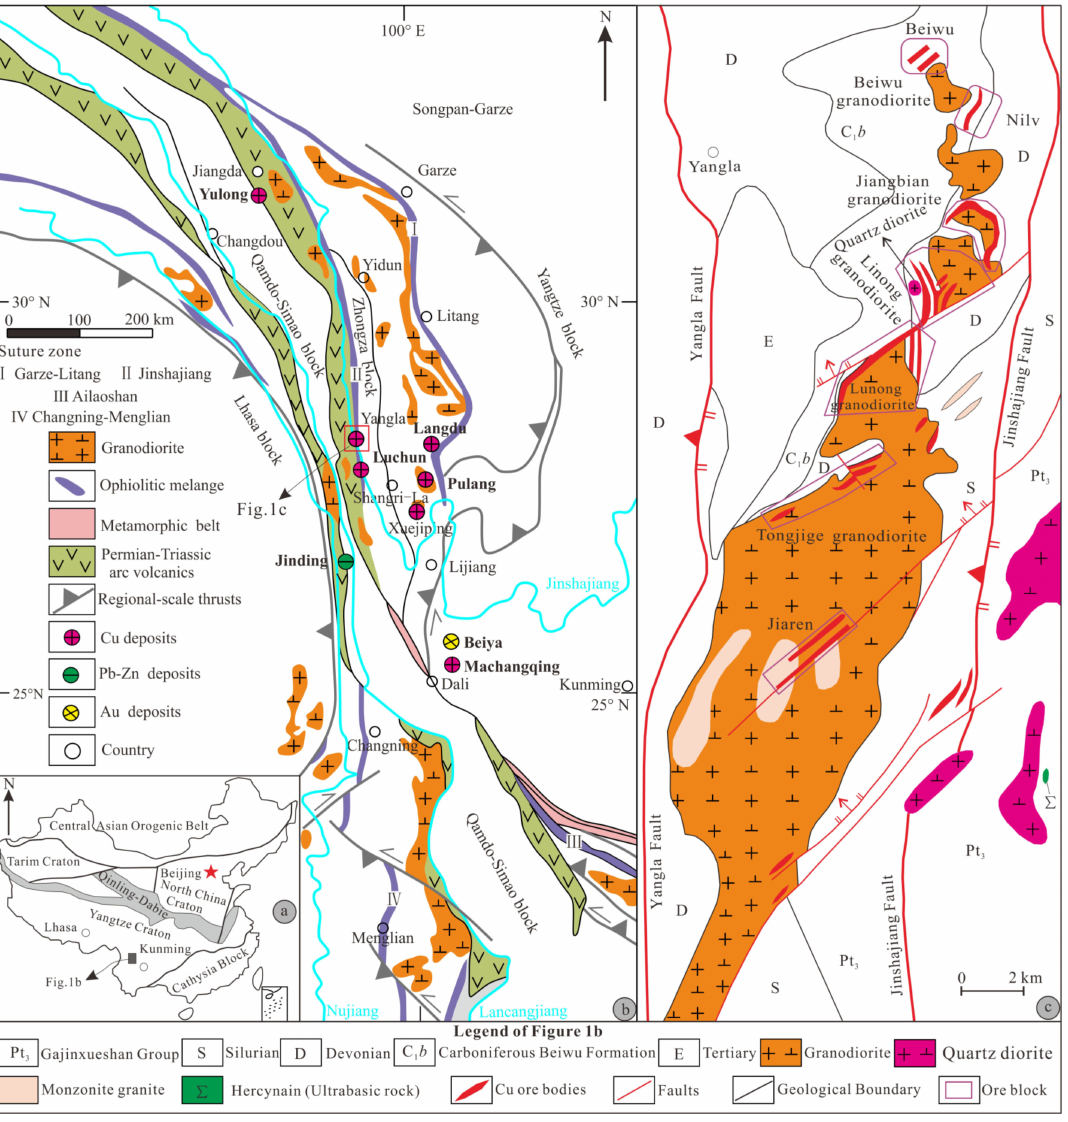
Figure 1. ( a ) Geotectonic framework sketch map of China [2]. ( b ) Regional geological sketch map of the Sanjiang region, southwest China [8]; ( c ) geologic sketch map of the Yangla Cu-W polymetallic deposit, northwest Yunnan, China